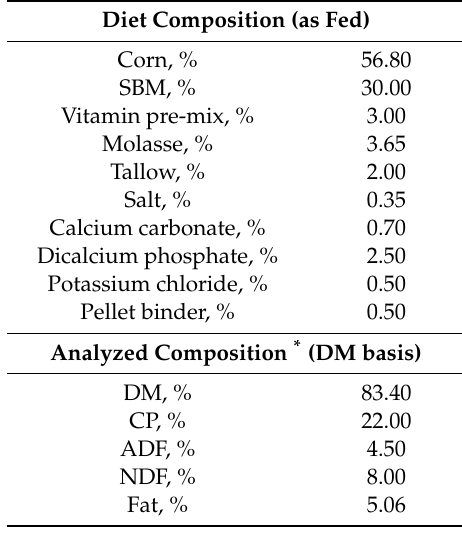
Table 1. Nutrient content and composition of sow